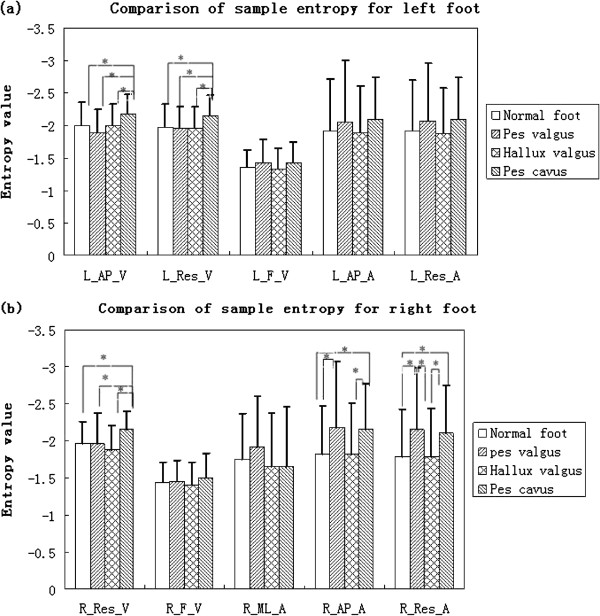
Multiple intercomparisons of means and standard deviations of sample entropy between normal foot, pes cavus, pes valgus and hallux valgus for ML and AP velocity and acceleration, resultant velocity and acceleration and force change rate. Comparison for variables of left foot (a) and right foot (b).